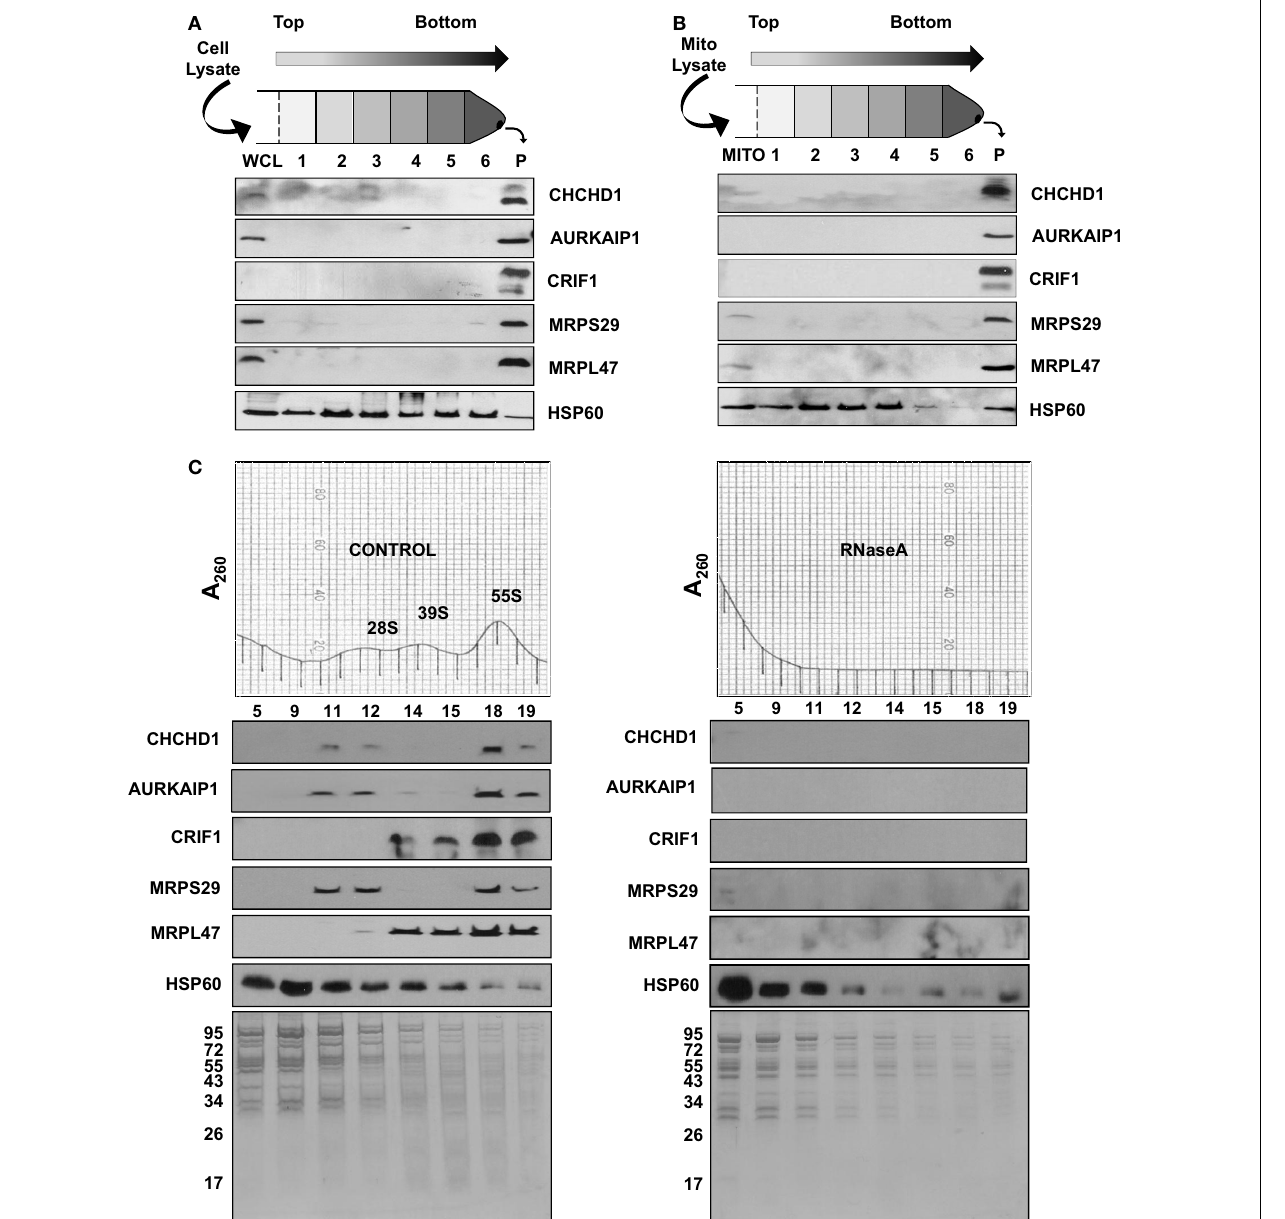
FIGURE 3 | Sedimentation of new MRPs with large complexes in human cell lines and mitochondria. (A) Whole cell lysate (WCL) and (B) mitochondrial lysate (MITO) obtained from human cell lines were layered on sucrose cushion preparations. After 16h centrifugation, post-ribosomal supernatant layers (Layers 1 to 6) and the crude ribosome pellet (P) were collected and analyzed by immunoblotting probed with CHCHD1, AURKAIP1, CRIF1, MRPS29, MRPL47, and HSP60 antibodies. (C) To confirm the RNA-dependentassociation of new MRPs with mitochondrial ribosomes, the